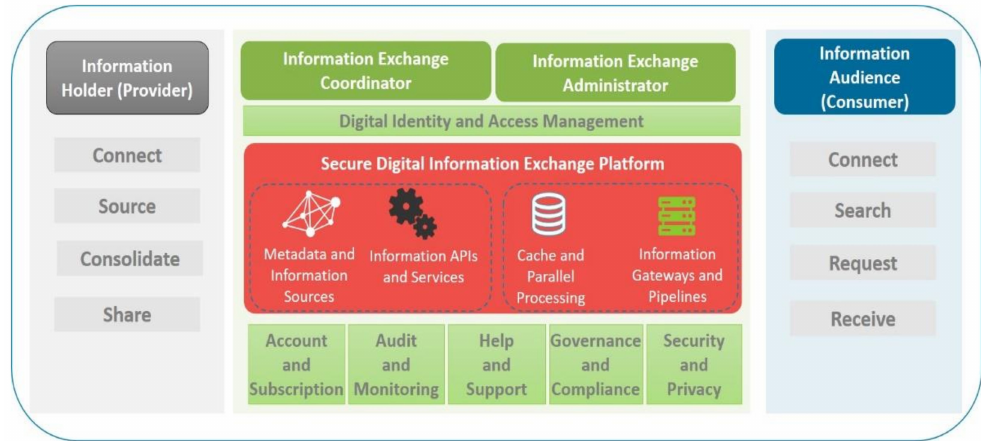
Figure 3. Digital information exchange: a conceptual